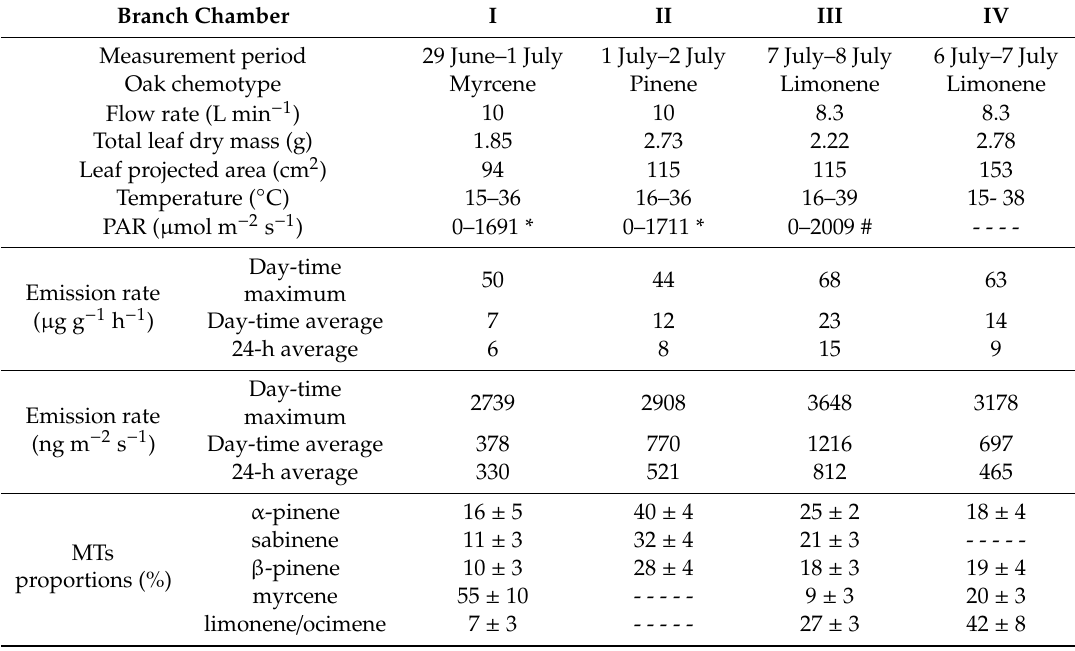
Table 2. Summary of the operational conditions, meteorological parameters, mean and maximum emission rates of total MTs and the proportions of individual MTs for the four branch